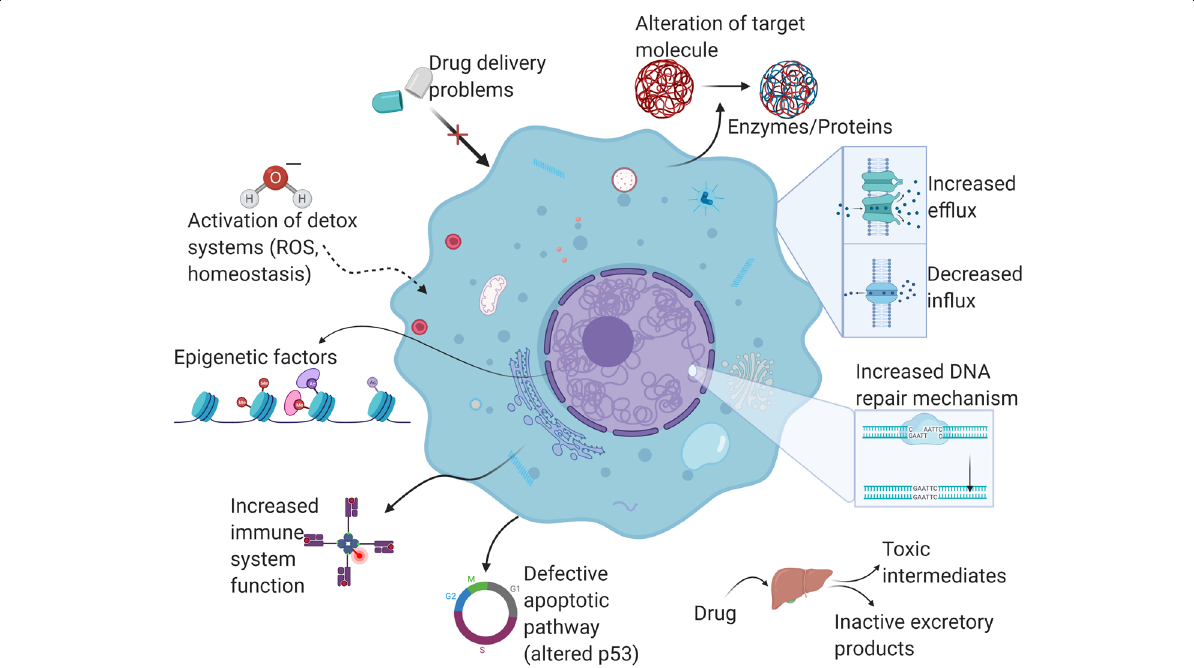
Fig. 2 Mechanisms by which drug resistance is conferred in cancer. (In clockwise manner starting with defective apoptotic pathway) (1) the apoptotic pathway (p53 pathway) might be defective, which leads to various downstream resistance mechanisms like upregulation of Nrf2 expression, MGM2 upregulation, increased cell proliferation, etc.; (2) drug resistance is seen when there is increased or defective immune system function where hypersensitivity is observed; (3) a plethora of epigenetic factors play roles in conferring drug resistance in cancer; (4) when the detox systems (ROS, homeostasis) are activated, there is a detox of the drug from the cancer cell; (5) drug delivery problems: too low concentration or higher molecule size than required; (6) drug alteration by intrinsic enzymes or other proteins; (7) transporters of the cell membrane exhibit increased drug efflux or decreased influx; (8) even if the drug enters the cell and affects the genetic machinery, there is an increased intrinsic DNA repair mechanisms; (9) drug resistance is also seen during increased metabolism in